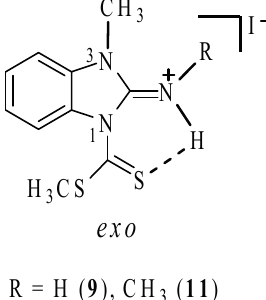
Figure 1. Endo conformers of compounds 10 and 12 and exo ones of compounds 9 and 11